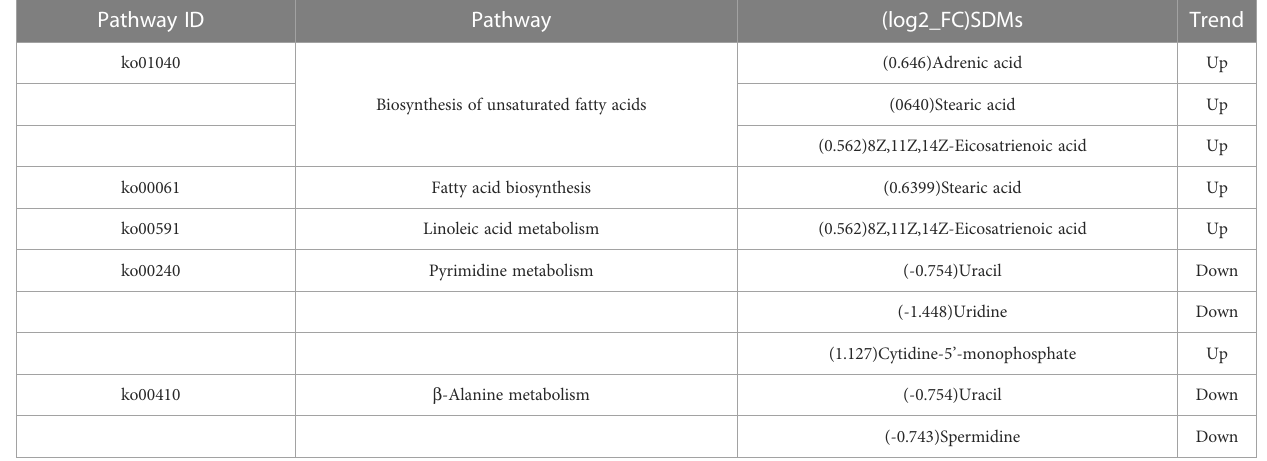
TABLE 3 Pathways involved by differential metabolites of juvenile Trachinotus ovatus under low-temperature stress. Pathway ID